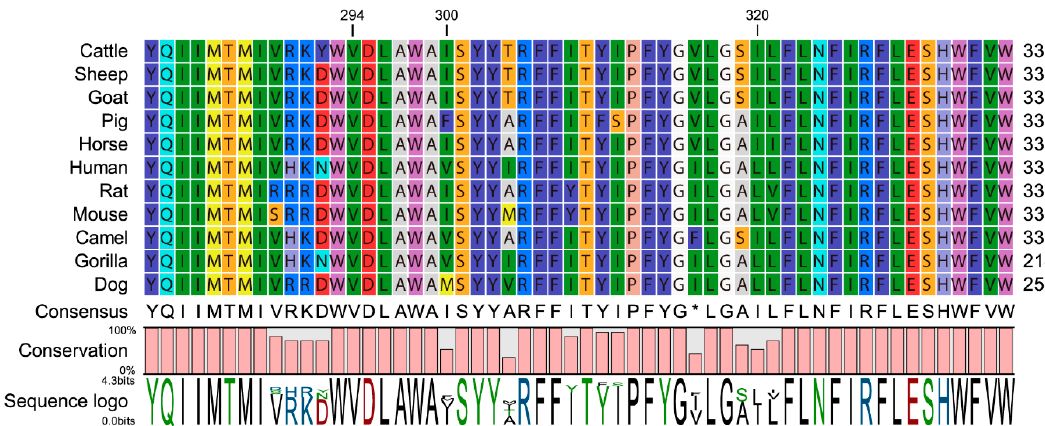
Figure 3. Multiple alignments of fatty acid desaturase 2 protein sequences from mammalian species. The position of Ala294Val mutation is indicated by the vertical line. The numbers on the right are relative positions of amino acid.